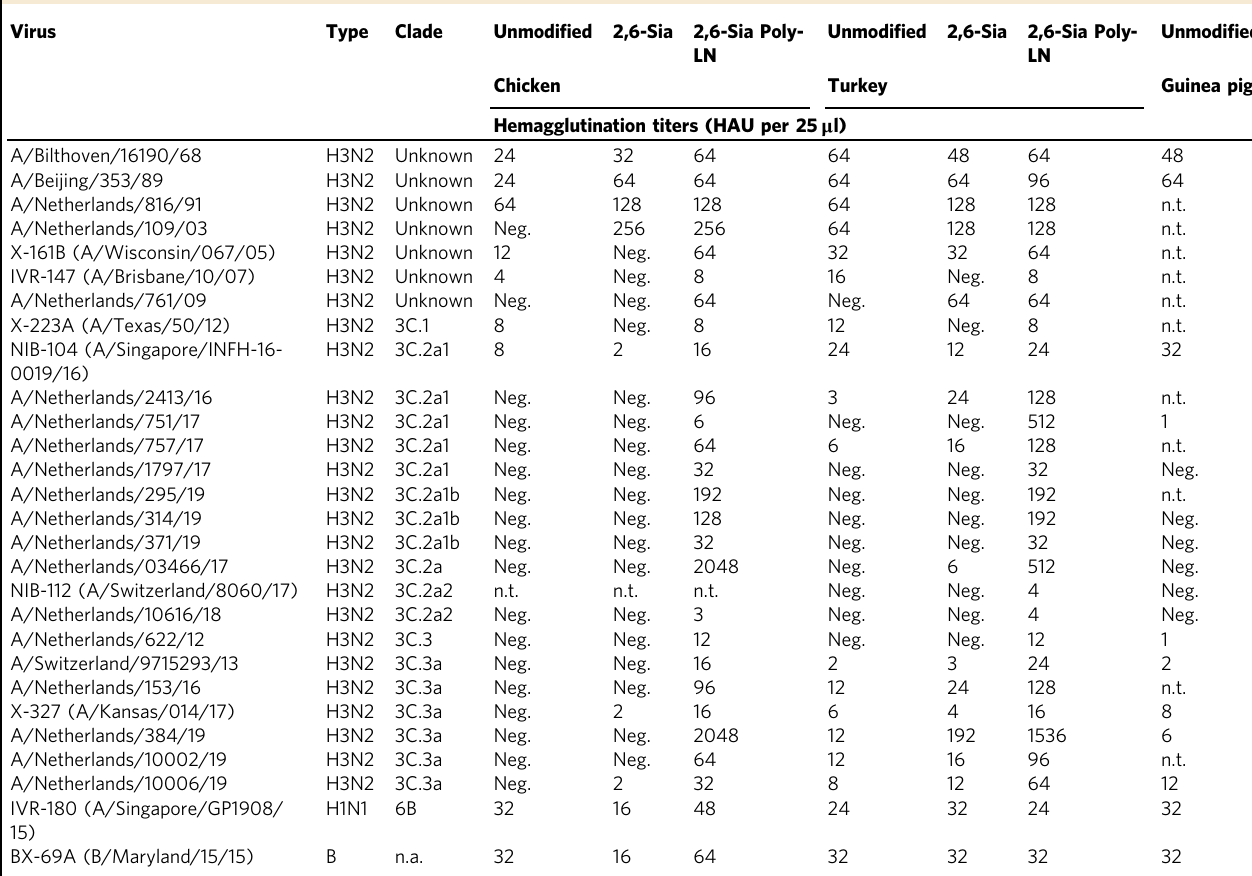
Table 1 Hemagglutination assay of A/H3N2 virus isolates using unmodi fi ed and 2,6-Sia Poly-LacNAc fowl erythrocytes and unmodi fi ed guinea pig erythrocytes.